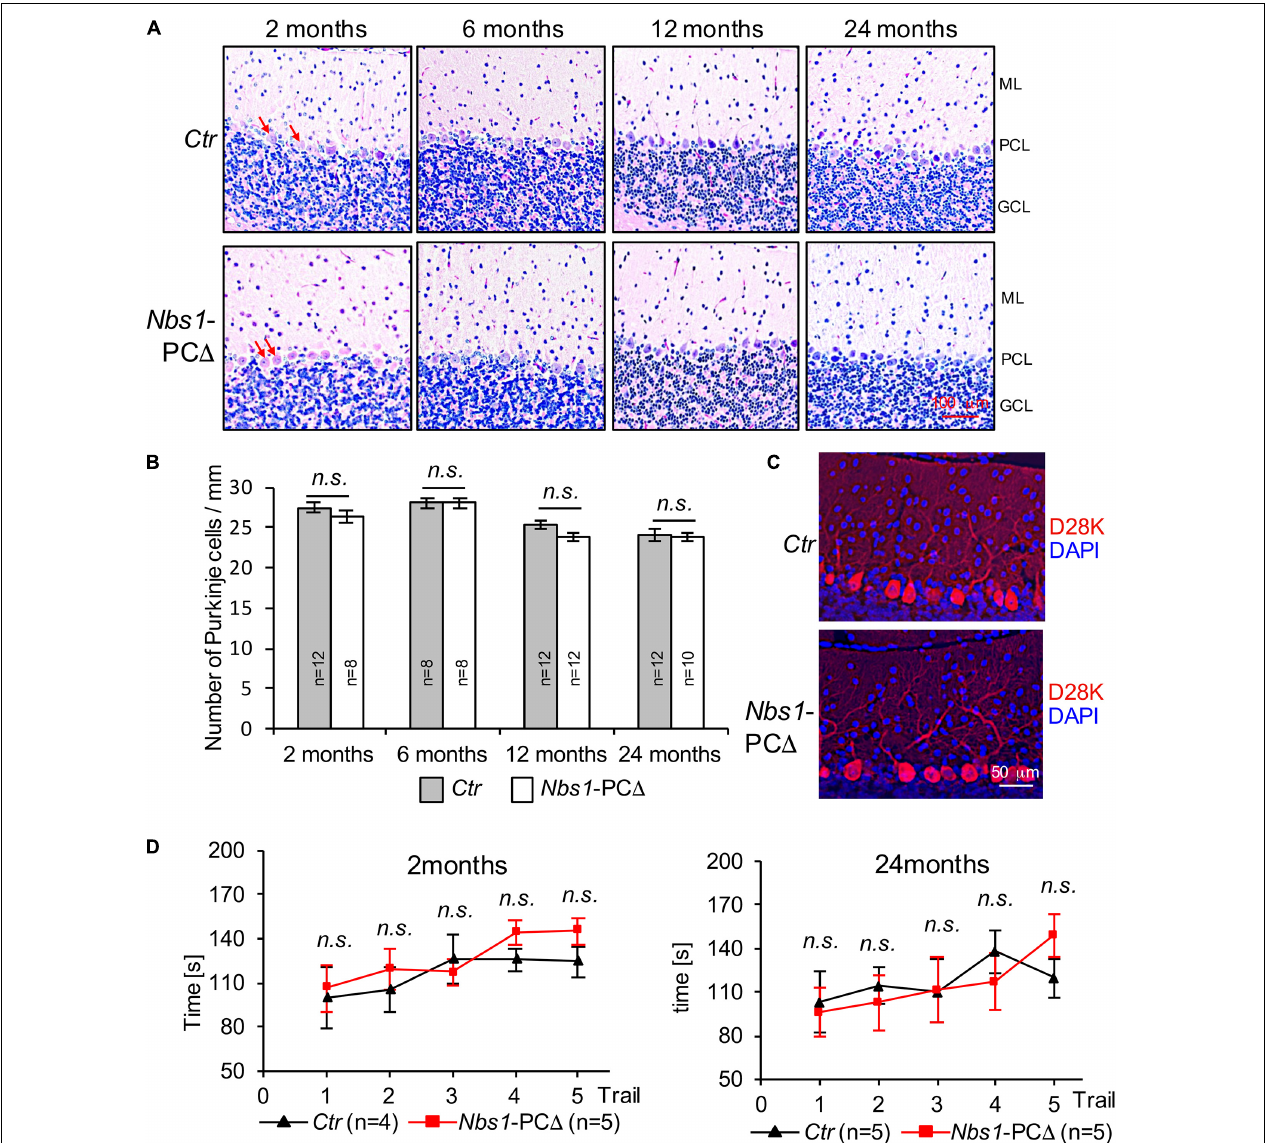
FIGURE 3 | Nbs1 -PC (cid:49) mice show normal cerebellar morphology and the density of Purkinje cells. (A) Hematoxylin and eosin staining (H&E) of sagittal cerebellar sections of control ( Ctr ) and Nbs1 -PC (cid:49) mouse of the indicated age. The middle region of the lobule V of the cerebellum is shown. ML: molecular layer, PCL: Purkinje cell layer, GCL: granular cell layer. Arrows point to Purkinje cells. (B) Quantification of Purkinje cell number of the cerebellum of the control ( Ctr ) and the Nbs1 -PC (cid:49) mouse at the indicated age. The data is represented as the number of Purkinje cells per micrometer of the lobule V. The number of mice is indicated within the bar. The Student’s t -test is performed for the statistical analysis between control and Nbs1 -PC (cid:49) . n.s., not significant. (C) Morphology of Purkinje cells was analyzed by immunostaining with Calbindin-D28K (D28K) for Purkinje cells and DAPI for the nucleus of 2-month-old control ( Ctr ) and Nbs1 -PC (cid:49) mouse brain sagittal sections. Representative images of the middle region of the lobule V of the cerebellum from two mice are shown. (D) Nbs1 -PC (cid:49) mice have the normal locomotor capability. The rotarod performance of 2-month-old (left) and 24-month-old (right) mice on five consecutive days with the indicated number of control ( Ctr ) and Nbs1 -PC (cid:49) mice. The Student’s t -test is performed for the statistical analysis between control and Nbs1 -PC (cid:49) at each trial. n.s., no